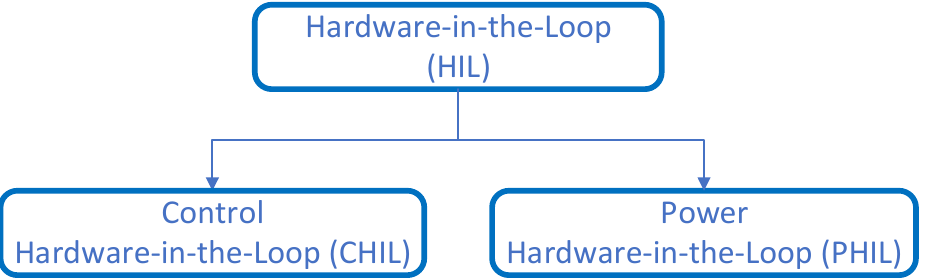
Figure 1. Two HIL configurations of CHIL and PHIL.